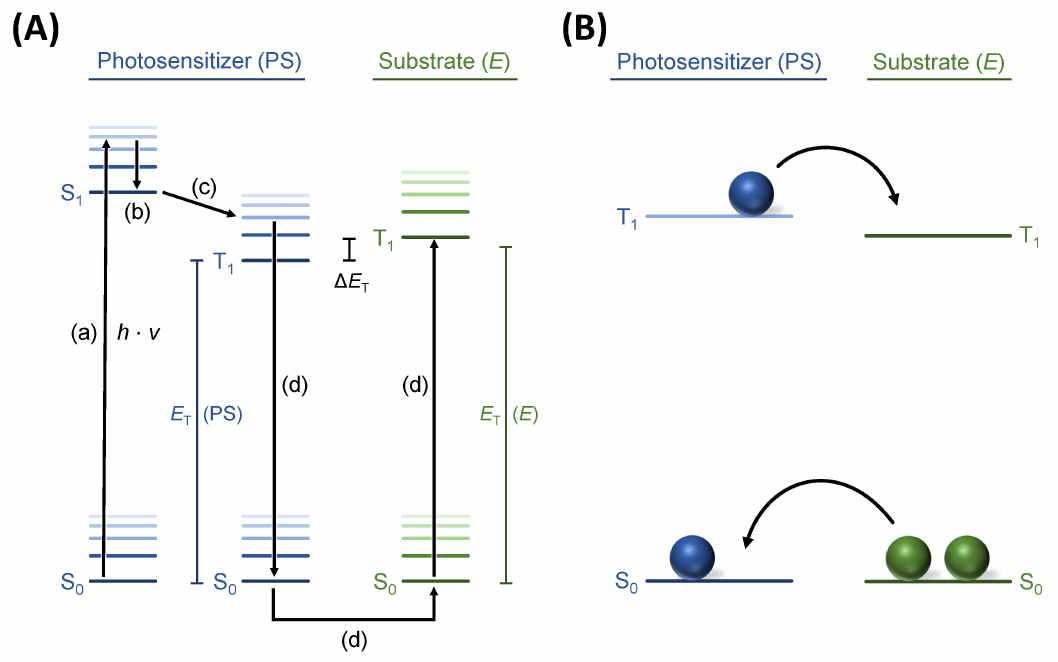
Figure 1. Energy transfer mechanism from a photosensitizer to a substrate in the photocatalyzed ( E )-/( Z )-isomerization. ( A ): (a) The photosensitizer is excited by irradiation of light from the singlet ground state S 0 into the S 1 state; (b) the sensitizer relaxes from higher vibrational/rotational S 1 states to the lowest S 1 state; (c) ISC from S 1 state to T 1 state; (d) upon collision of the photosensitizer with the substrate, energy from the catalyst is transferred to the substrate in a coupled transition. ( B ) “Dexter Energy Transfer”: upon collision, an electron (sphere) in the T 1 state of the sensitizer is transferred in the T 1 state of the substrate, while an electron of the S 0 state of the substrate is transferred to the S 0 state of the sensitizer, yielding a relaxed sensitizer and an excited